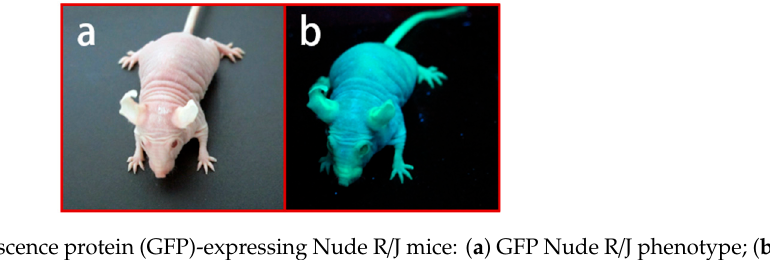
Figure 2. Nude R/J mice: ( a ) BALB/c Nude Rag ‐ 2/Jak3 double ‐ deficient (Nude R/J) hairless phenotype; ( b ) direct visualization of subcutaneous tumor nodules in Nude R/J; ( c – d ) fluorescent signals observed in Nude R/J.